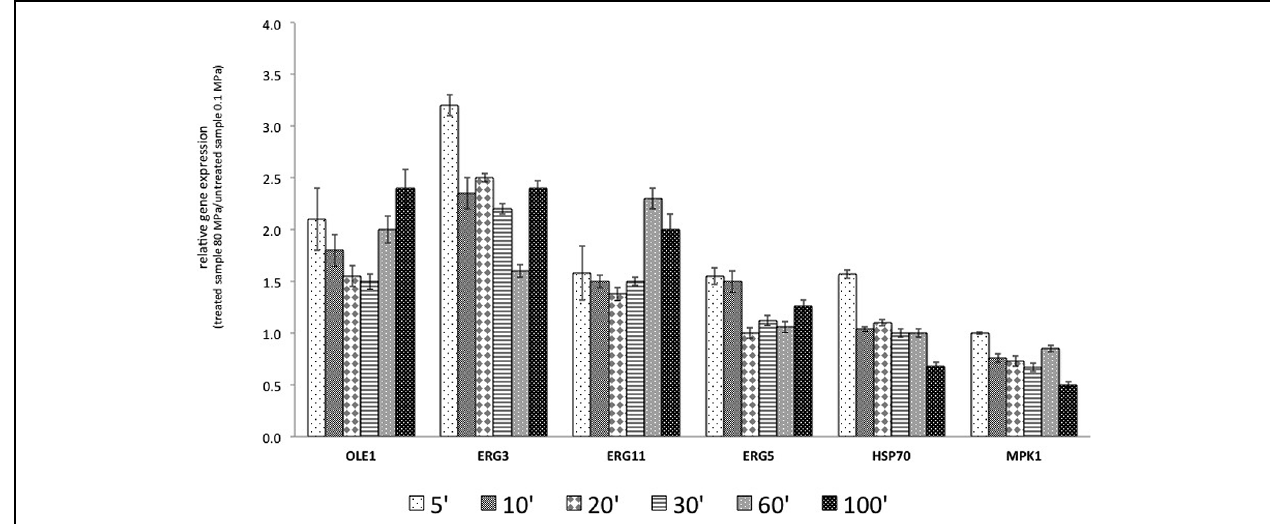
FIGURE 3 | Relative gene expression (RGE) calculated with the samples treated at 0.1 MPa, as a control, and samples treated, at 80 MPa representing sub-lethal stress at 5, 10, 20, 30, 60, and 100 min after the start of treatment. The gene products included OLE1 , a delta-9 monounsaturated fatty acid (FA) desaturase; ERG3 , a C-5 sterol desaturase; ERG11 , a lanosterol 14-alpha-demethylase; ERG5 , a C-22 sterol desaturase; HSP70 , an hsp70 family ATPase; and MPK1 , a serine/threonine MAP kinase. The reported values are statistically significant ( p < 0.01).